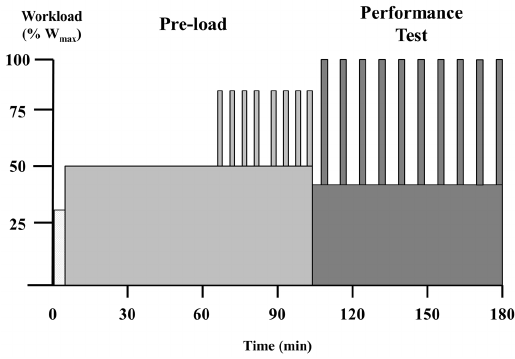
Figure 1. Exercise protocol. W max , peak cycling power.